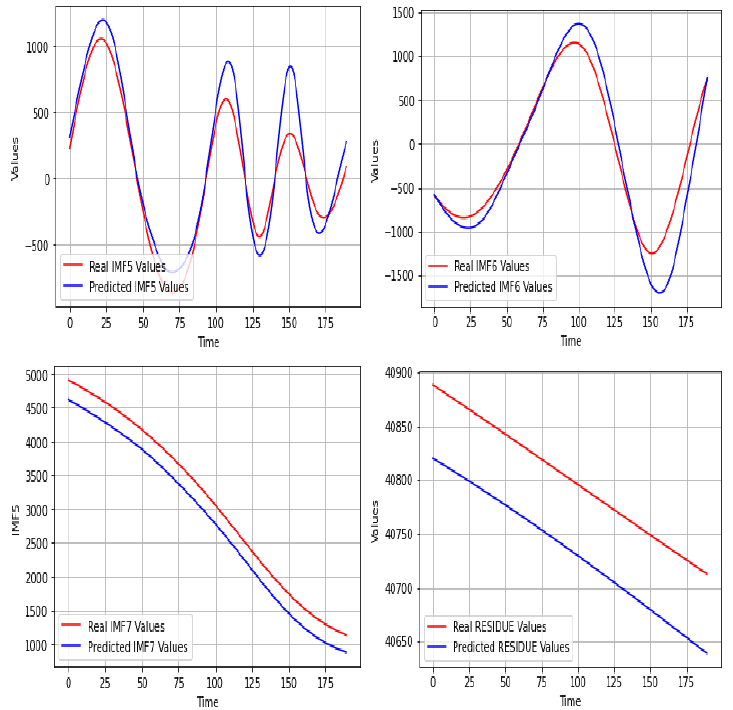
Figure 8. Predicted results of correlated subcomponents obtained from SEMD-LSTM model.